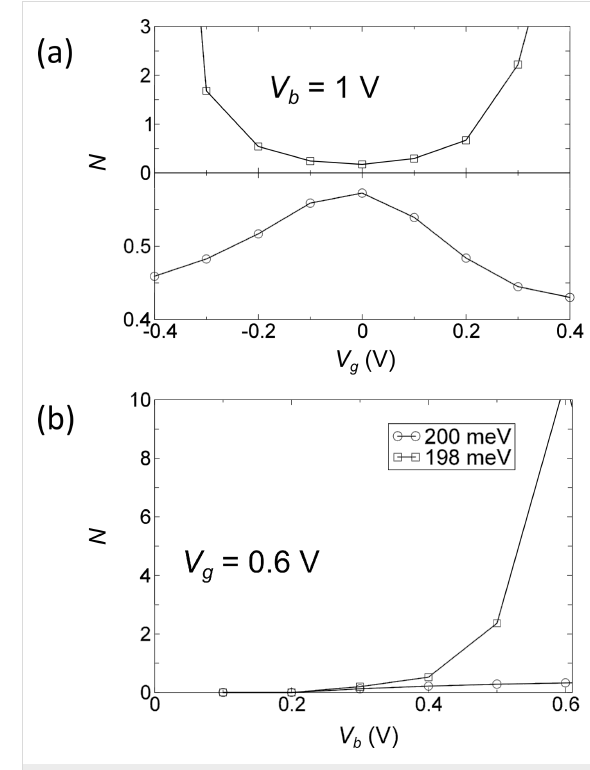
Figure 5: (a) Effective phonon number ( N ) for the two phonon modes around 200 meV as a function of gate voltage, V g , at fixed bias voltage, V b = 1 V. (b) N as a function of bias voltage, V b , at fixed gate voltage V g = 0.6 V. Note that it diverges at the critical point when the damping (1/ Q ) in Figure 4 goes to